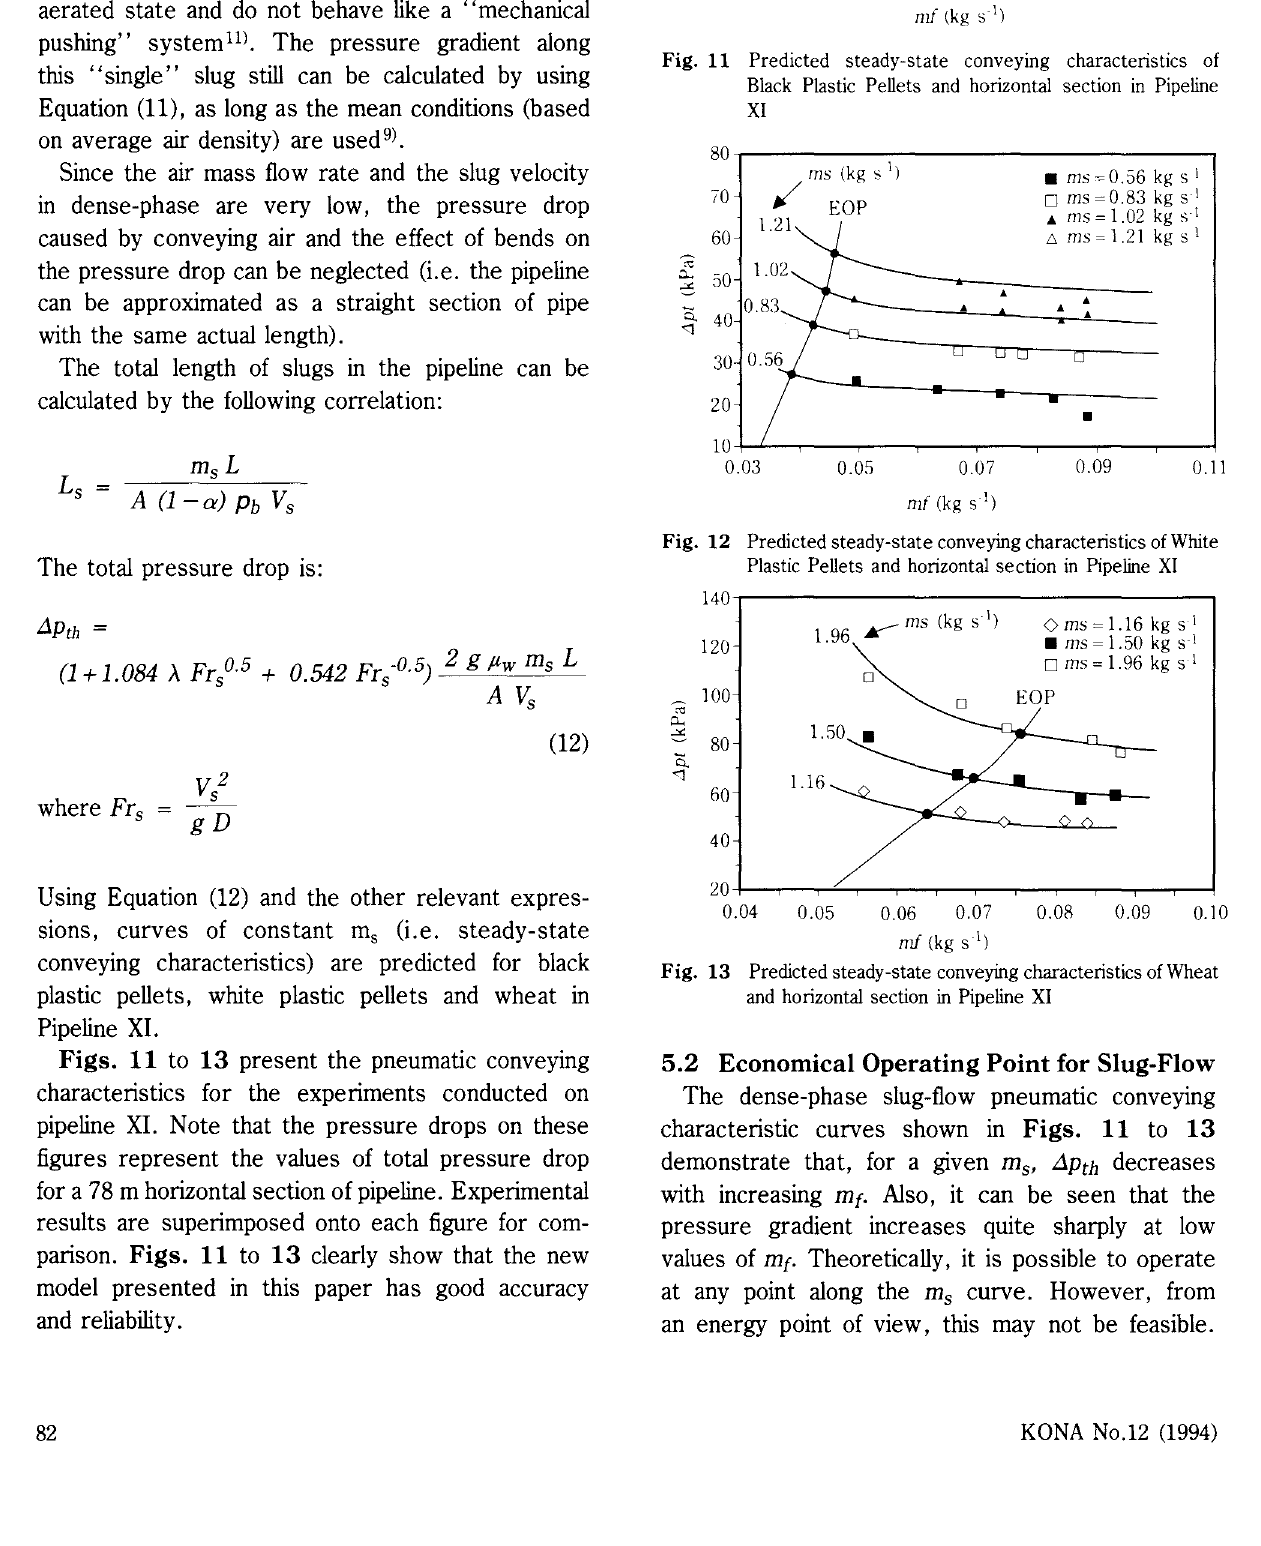
Fig. 12 Predicted steady-state conveying characteristics of White Plastic Pellets and horizontal section in Pipeline XI